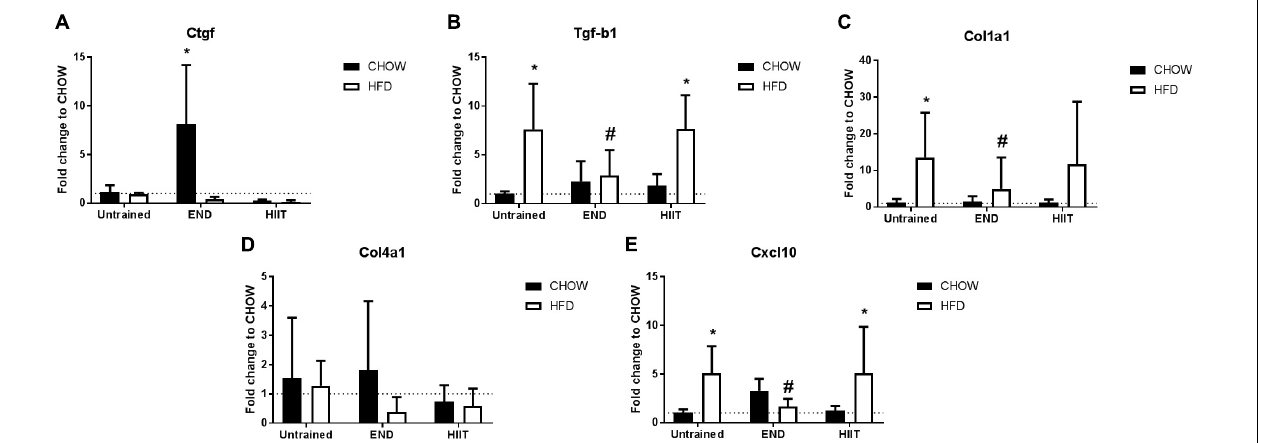
FIGURE 10 | Liver mRNA levels of extracellular matrix and inflammation-related genes. Connective tissue growth factor/CCN2 (Ctgf; A ), transforming growth factor beta (Tgf-b1; B ), collagen 1 alpha 1 (col1a1; C ), collagen 4 alpha 1 (col4a1, D ), and interferon gamma-induced protein 10 (Cxcl10; E ). Data are presented as means ± SD and the number of animals in each group is 2–9. ∗ p < 0.05 vs. CHOW untrained; # p < 0.05 vs. HFD untrained by Two-way ANOVA with Tukey’s and Sidak’s post hoc